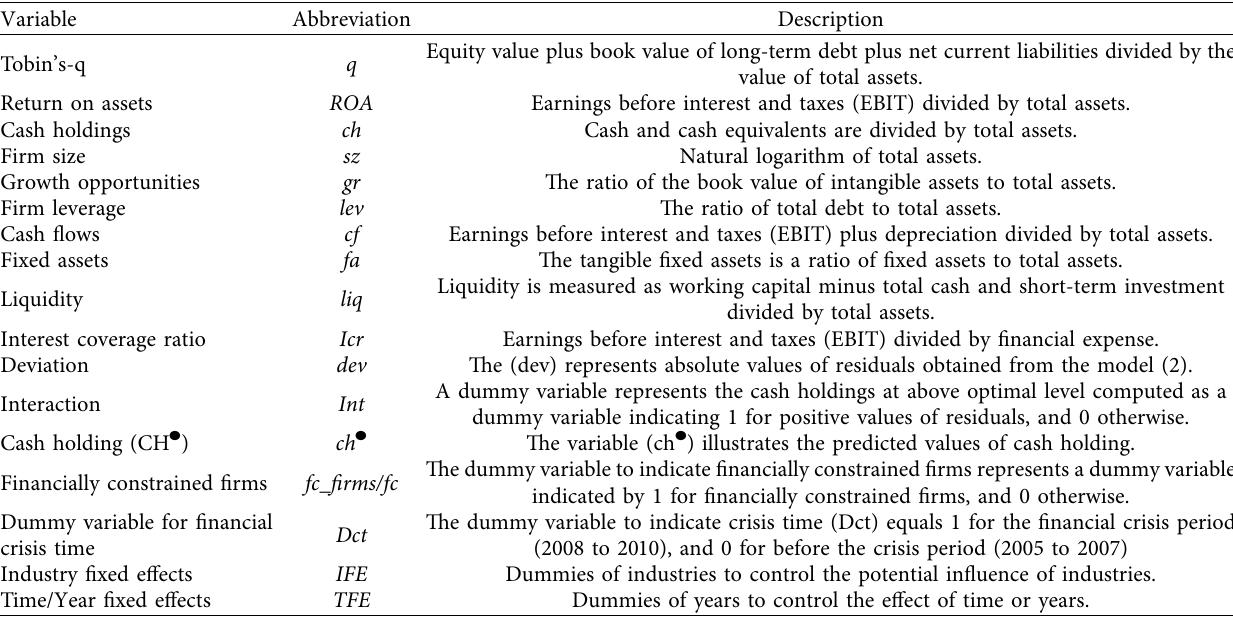
Table 11: Definition of variables.